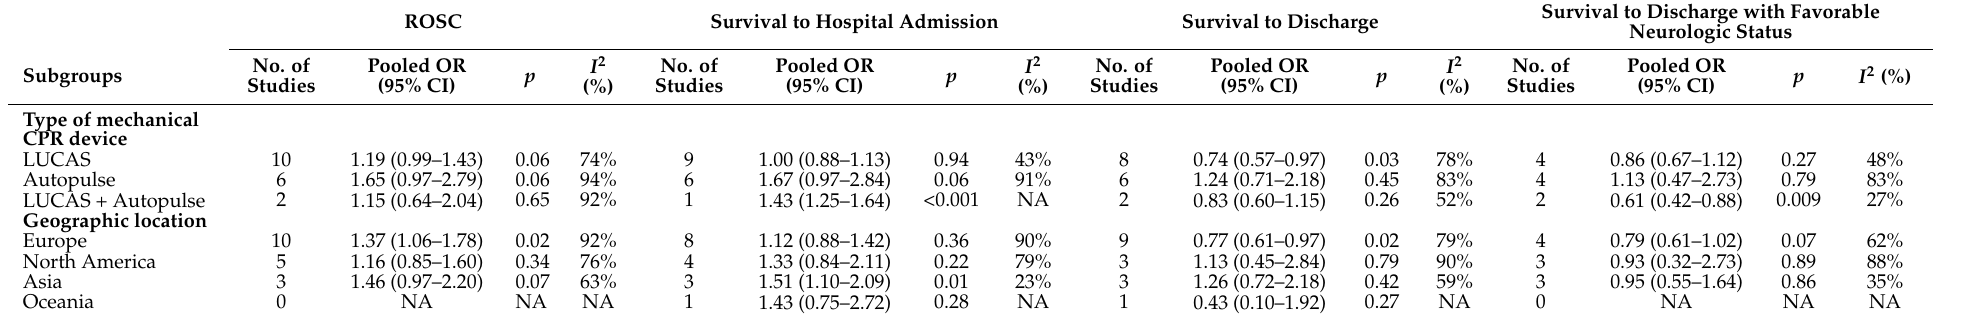
Table 2. Subgroup analyses of pooled odds ratios of primary and secondary survival outcomes of